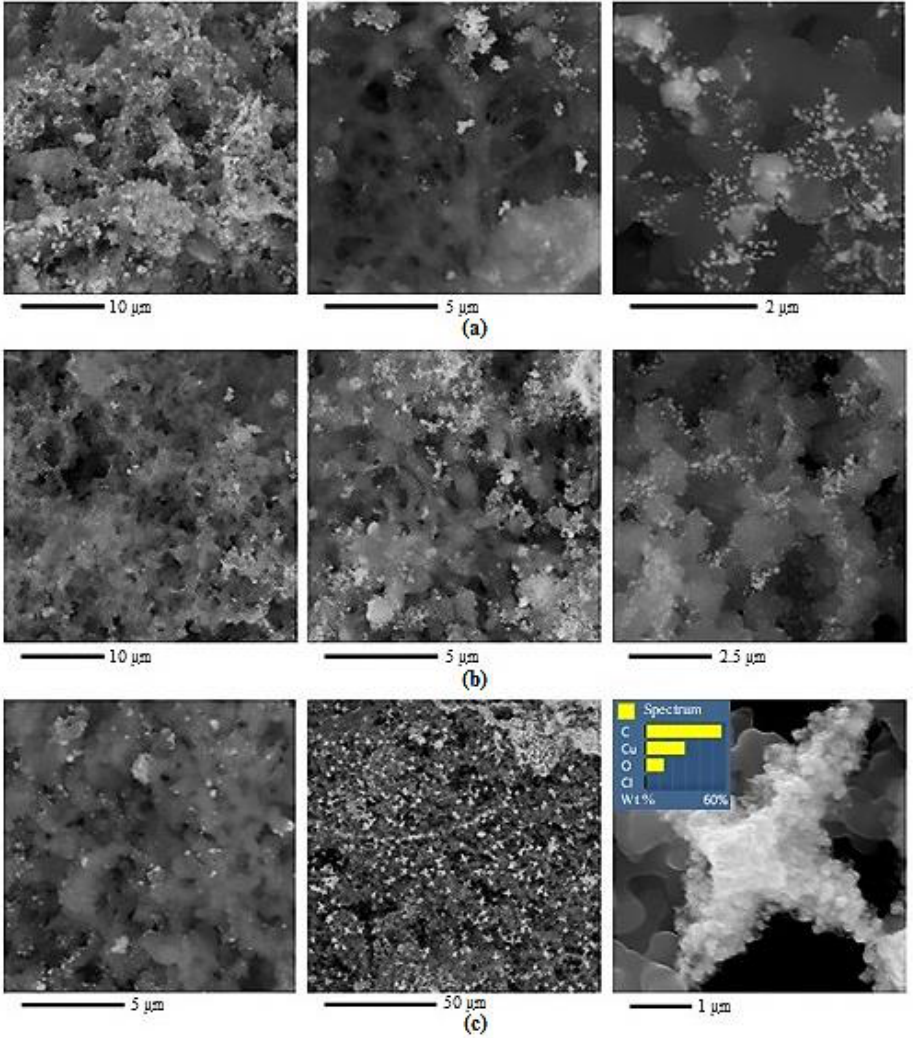
Figure 5. SEM images of AFP + Cu(NO 3 ) 2 composite samples heat treated at 400 °C ( a ), 500 °C ( b ) и 700 °C ( c ).